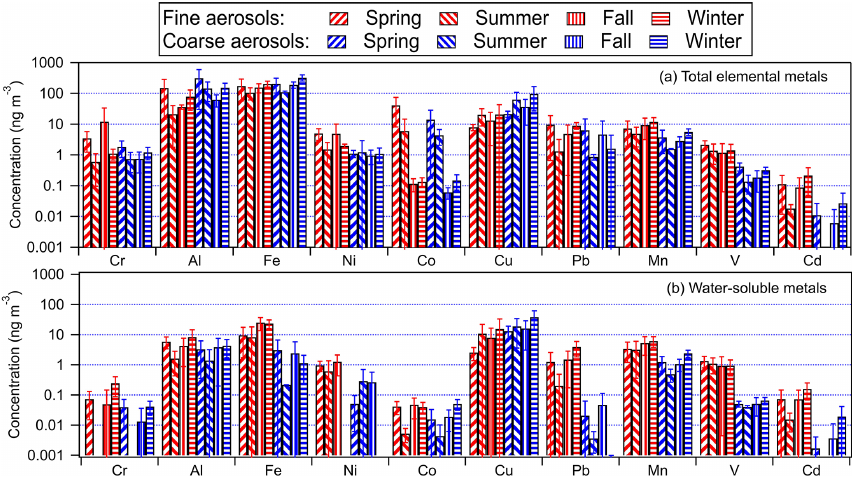
Figure 2. Seasonal average mass concentrations of (a) total metals and (b) water-soluble metals in fine (red) and coarse (blue) aerosols. The error bars represent 1 standard deviation. The y axes are on logarithmic